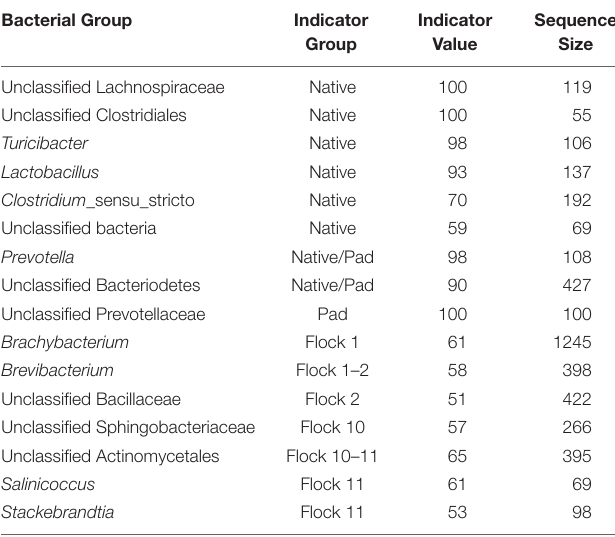
TABLE 2 | List of Indicator bacterial taxa associated with soils collected from different flocks. Bacterial Group Indicator